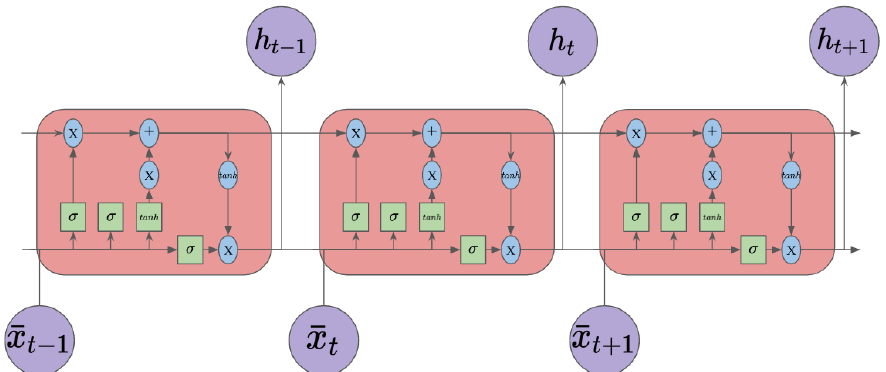
Figure 5. A single LSTM unit.